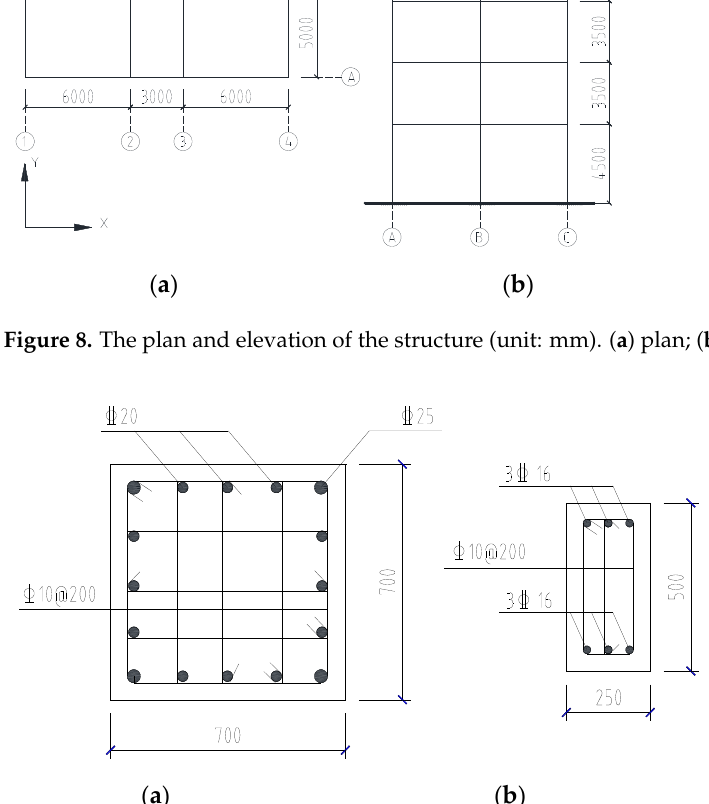
Figure 9. The reinforcement drawings. ( a ) beam; ( b ) column.